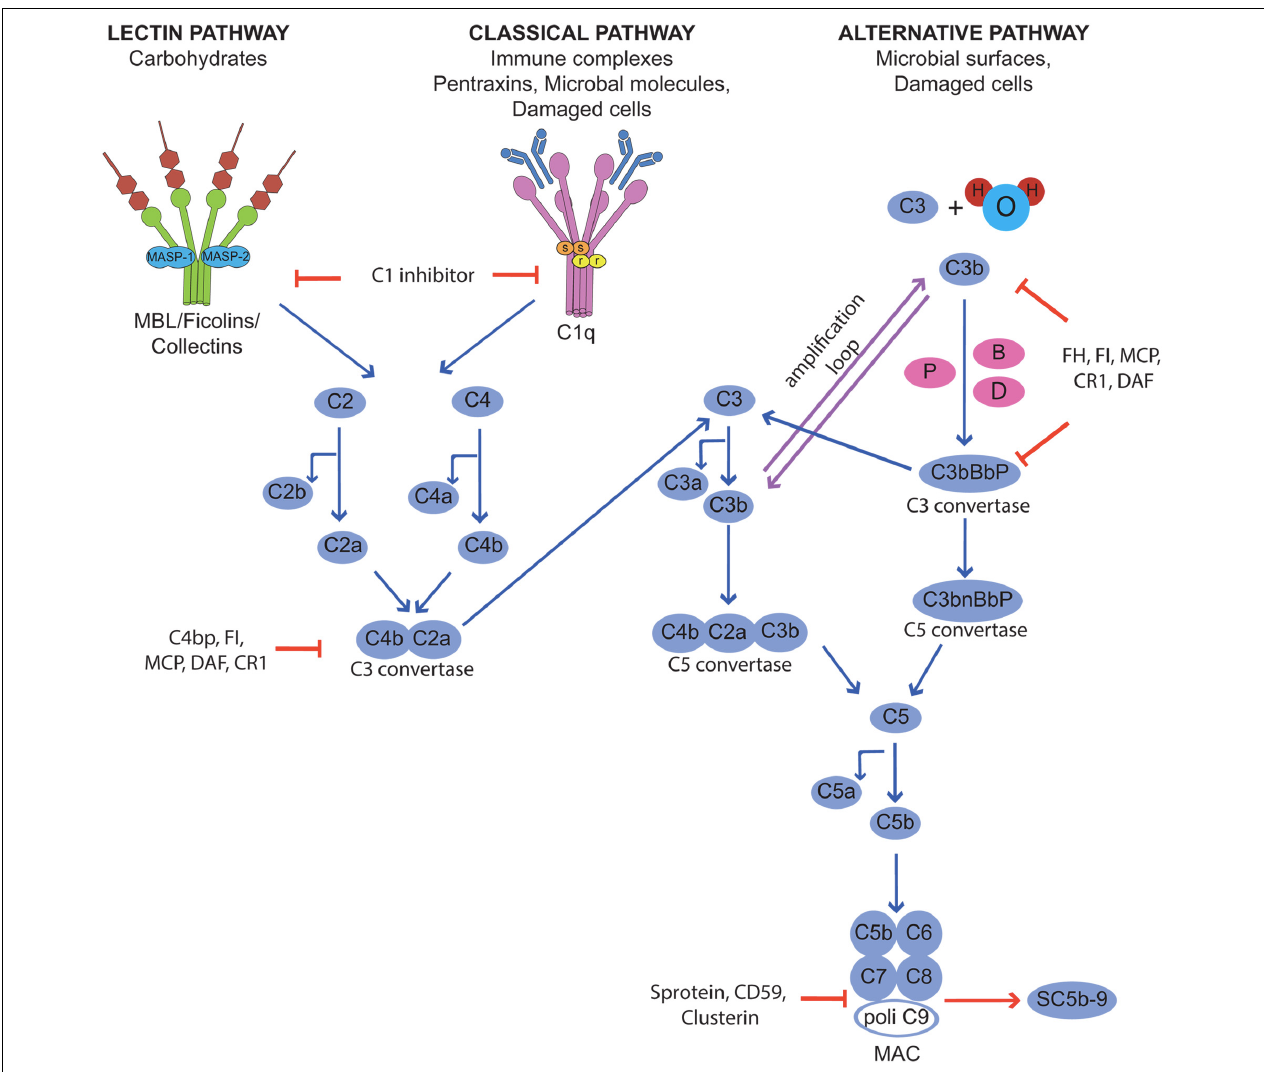
FIGURE 1 | Activation of the complement cascade through the classical, lectin, and alternative pathways and its control by regulators and